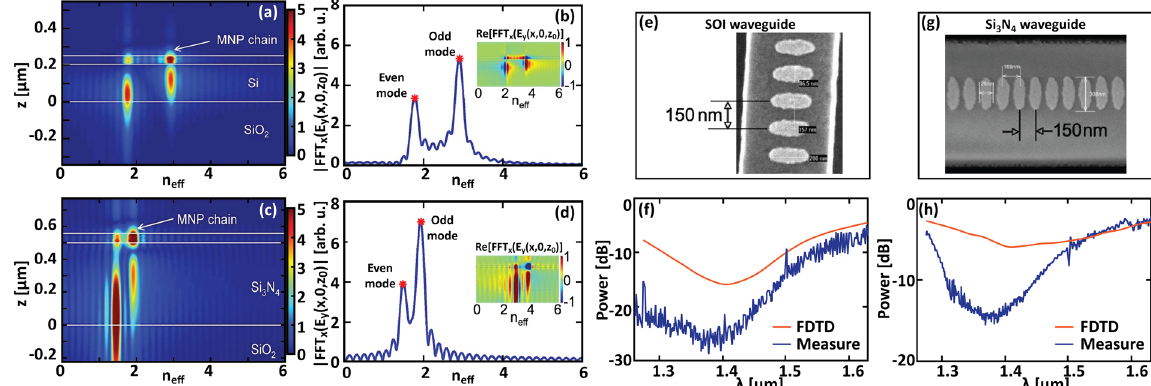
Figure 5. Spatial distributions and effective refractive indexes of supermodes revealed by the spatial Fast Fourier Transform (FFT) of the complex electric field E y . ( a )( c ) FFT module versus the effective index and the z -coordinate on in the [x, z] symmetry plane of the structure. ( b ),( d ) FFT module calculated versus the effective index when z corresponds the LSPWG axis. Inset: real part of the FFT. In ( a ) and ( b ) a LSPWG/SOI system is considered, whereas ( c ) and ( d ) are calculated for the LSPWG/Si 3 N 4 structure. ( e ) and ( g ) Scanning electron microscope images of gold nanoparticles deposited on top of SOI and Si 3 N 4 waveguides, respectively. ( f ) Transmission spectrum measured (blue curve) and calculated (red curve) for a SOI waveguide with a chain of 50 gold nanoparticles. ( h ) Same as ( f ) for a Si 3 N 4 waveguide with a chain of 50 gold